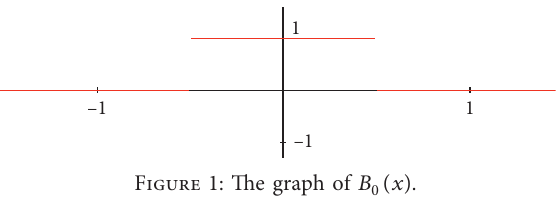
Figure 1: The graph of B